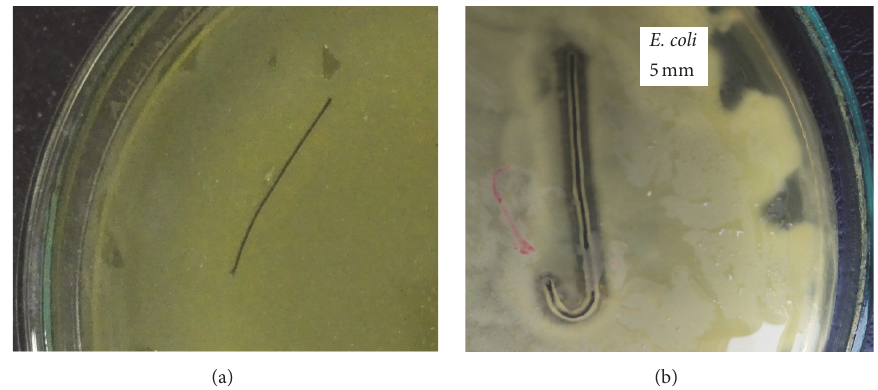
Figure 6: In vitro testing against E. coli of (a) uncoated suture and (b) coated suture.